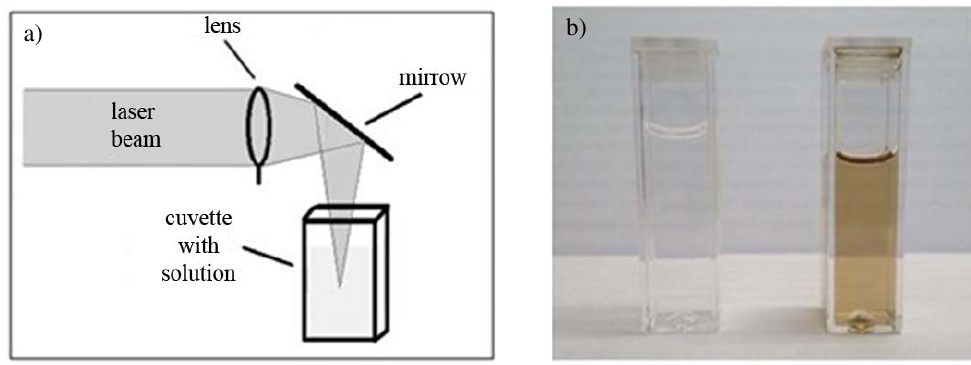
Fig. 2. Distribution of NP’s size was obtained using dynamic light scattering technique (Inset of Fig. 2). One may see that the size of the particles is changing from 25 to 100 nm and depends on concentration of the used so- lution; both separate Ag NPs and their agglomerations present in the solutions, but number of observed agglo- merates is